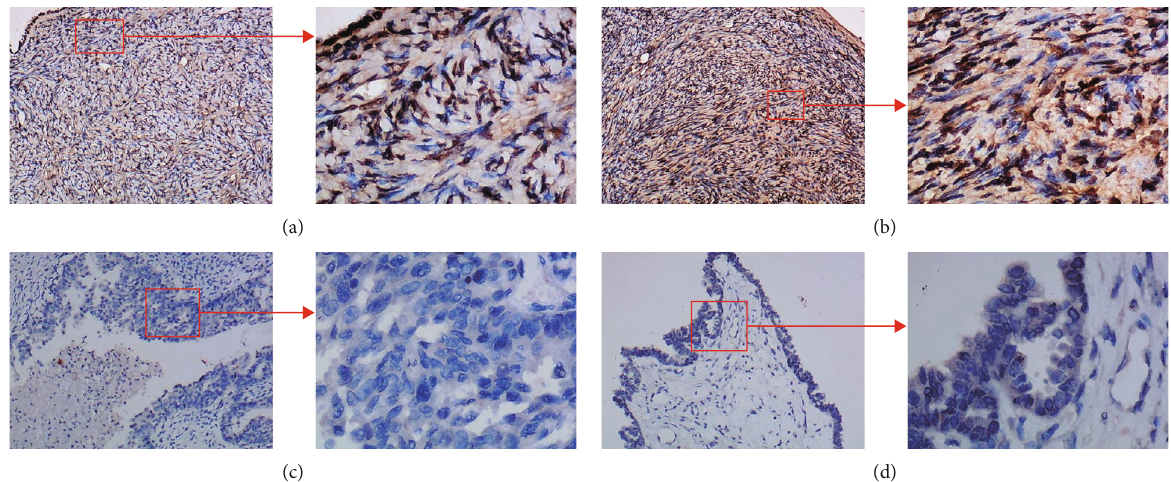
Figure 1: The expression of CCDC80 protein in normal ovary (a) and (b) and ovarian carcinoma (c) and (d) tissues through immunohistochemical (IHC)